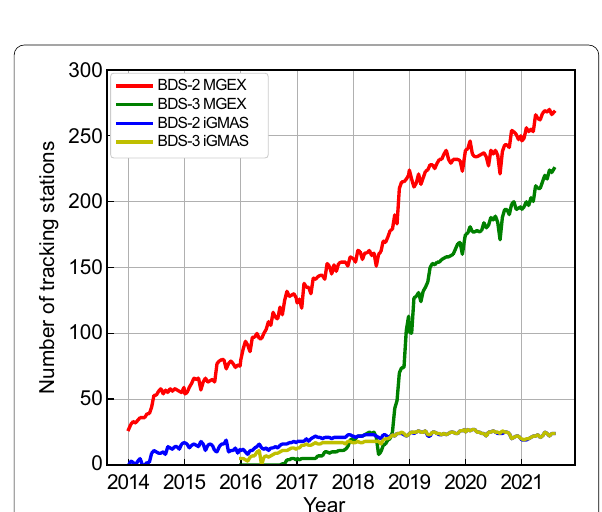
Fig. 3 The daily number of iGMAS and IGS stations with BDS-2 and BDS-3 tracking